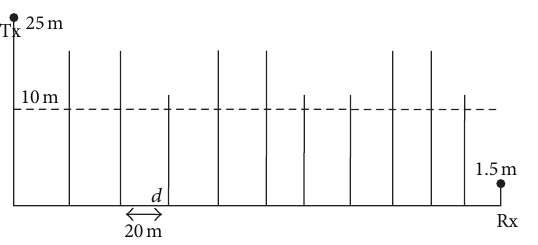
Figure 1: Scenario of comparison of GTD based